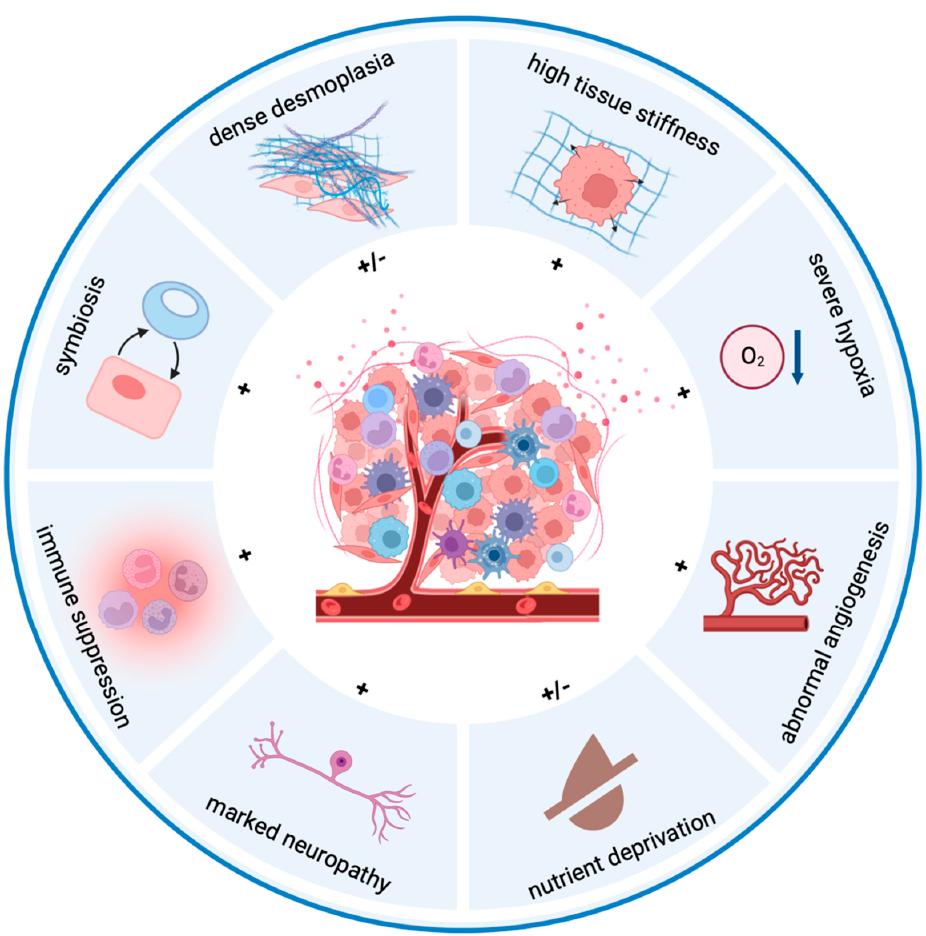
Figure 1. Hallmarks of the pancreatic tumor microenvironment. The unique features of the pancreatic tumor microenvironment compared to other solid cancers are summarized. Pancreatic cancer is composed of abundant stroma (fibroblasts, stellate cells, neuronal cells, endothelial cells, etc.) and immune suppressive cells. The dense extracellular matrix results in high tissue stiffness and severe hypoxia. The hyperproliferative tumor cells and active stroma deprive essential metabolites in situ, and the hostile milieu further exacerbates the exclusion of cytotoxic immune cells. Moreover, tumor cells benefit from cells of the tumor microenvironment to progress, migrate and escape from therapy. “+”, pro-tumor hallmarks; “ − “, anti-tumor hallmarks. Immune cells are another major component in the pancreatic TME. The major mye- loid cell populations include macrophages, neutrophils, monocytes, and dendritic cells (DCs). In response to inflammation, pancreas infiltrated macrophages drive the acinar-to-